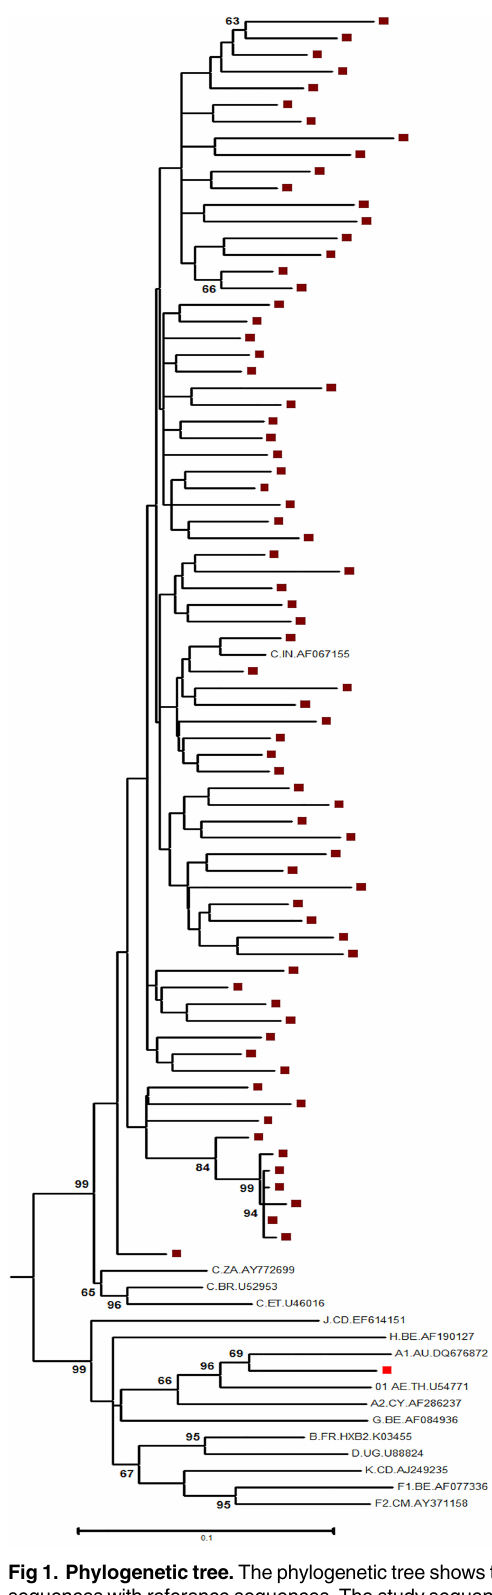
Fig 1. Phylogenetic tree. The phylogenetic tree shows the relationshipof 75 partial pol gene study sequenceswith reference sequences.The study sequencesare highlightedby solid circles. https://doi.org/10.1371/journal.pone.0181889.g001 PLOS ONE | https://doi.org/10.1371/journal.pone.0181889 August 1,